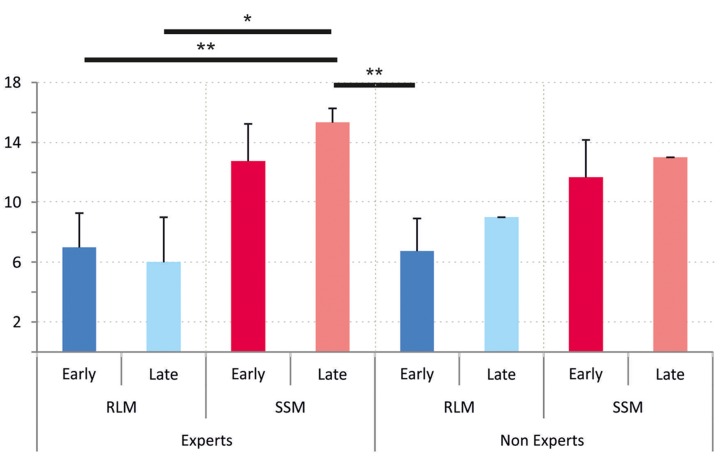
Scores to geographical questions according to onset of blindness and spatial expertise. Error bars represent standard deviation. (RLM, Raised-Line Maps; SSM, Small-Scale Model). Effects of the Tukey post hoc pairwise comparisons (∗p < 0.05, ∗∗p < 0.01).